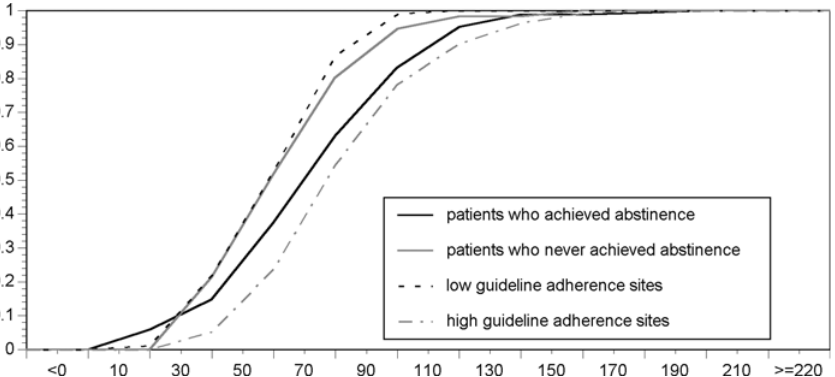
Figure 1. Cumulative Dose Histogram Depicting the Proportion of Patients at or below a Given Methadone Dose (in mg) Black line: methadone doses received while patients maintained heroin abstinence ( n ¼ 168). Gray line: average methadone doses received by patients who never achieved heroin abstinence ( n ¼ 54). Black dashed line: average methadone doses received by patients at low guideline-adherence clinics ( n ¼ 88). Gray dashed line: average methadone doses received by patients at high guideline-adherent clinics ( n ¼ 134). DOI: